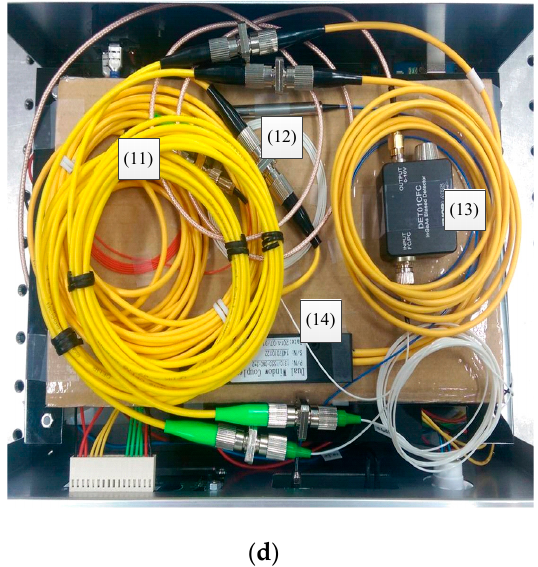
Figure 7. The developed prototype: ( a ) front view; ( b ) back view; ( c ) lower layer; ( d ) upper layer.